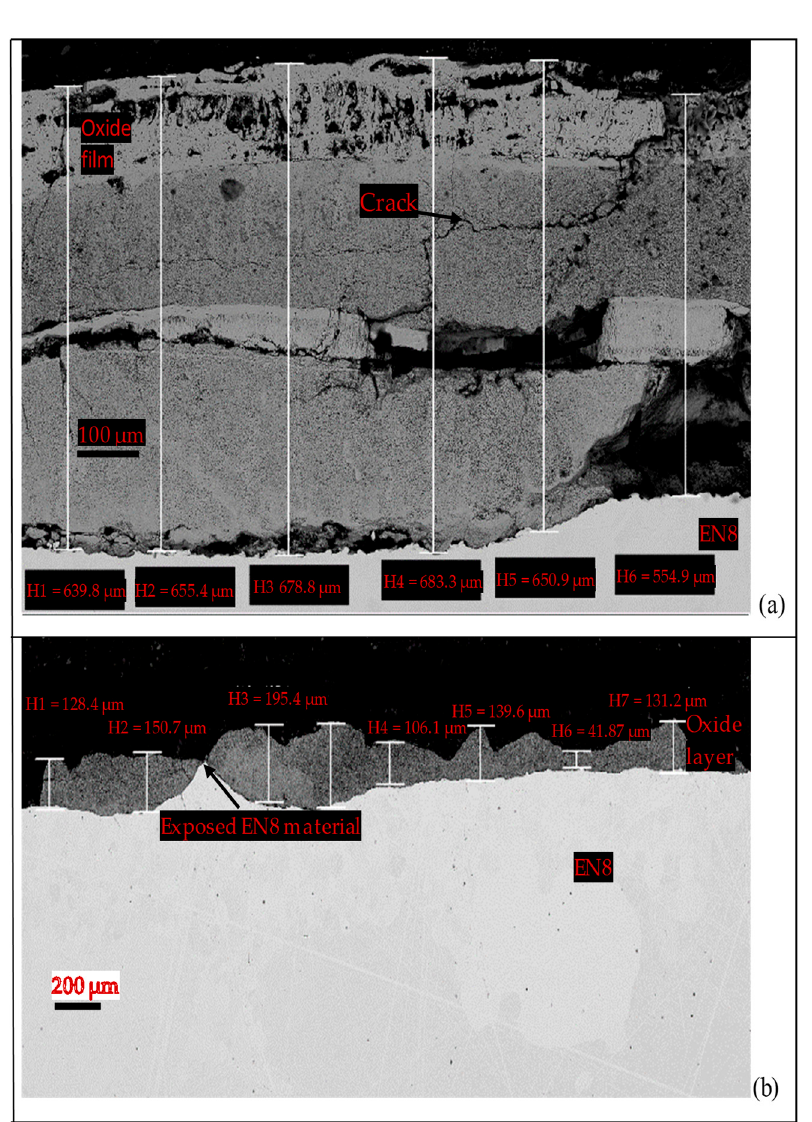
Figure 6. EN8 oxide film thickness at ( a ) t > 24 h and ( b ) t = 120